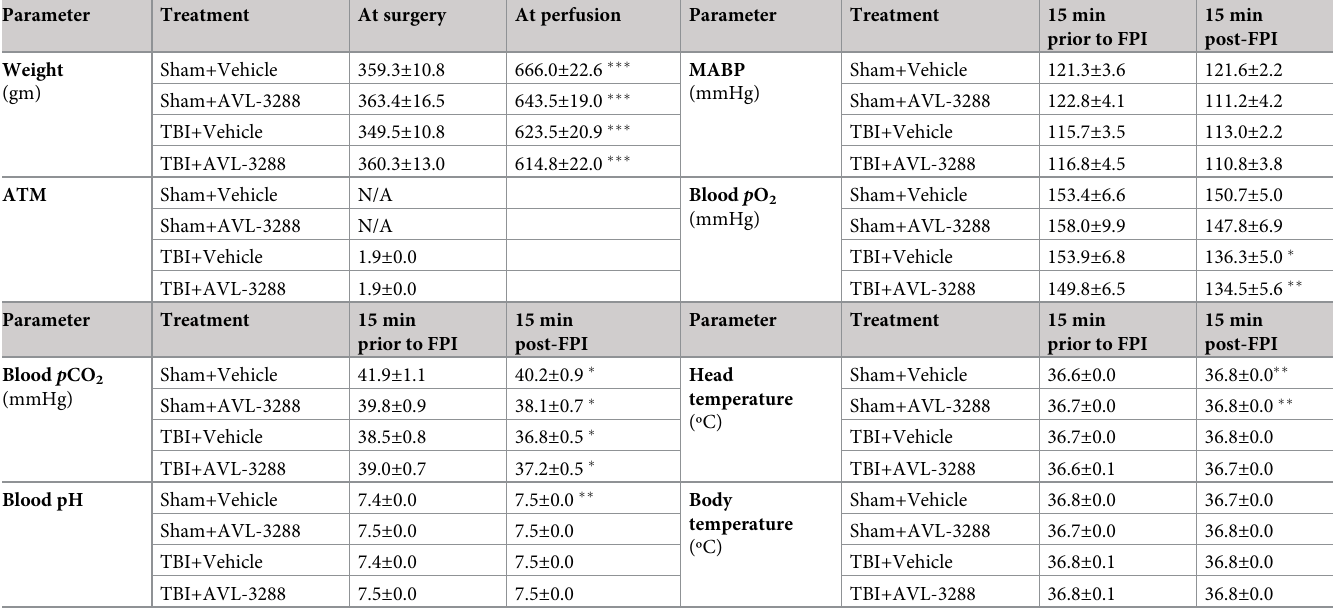
Table 1. Physiological data. Parameter